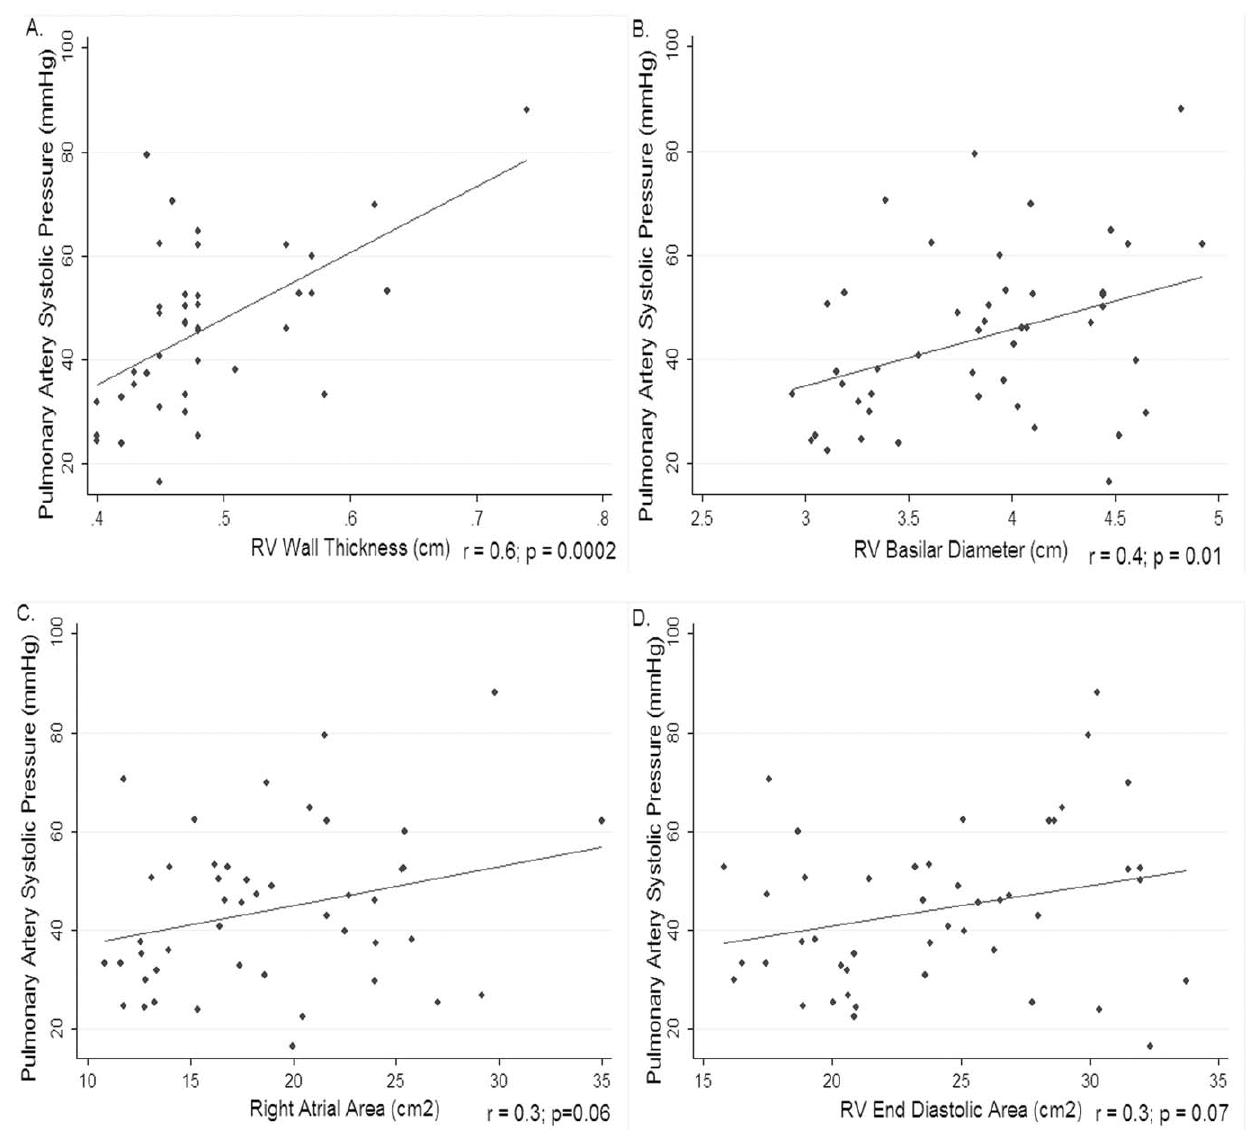
Figure 1. The correlation between right ventricular echocardiographic parameters and pulmonary artery systolic pressure estimates. Panel 1A: The correlation between pulmonary artery systolic pressure (mmHg) and right ventricular wall thickness (cm). Panel 1B: The correlation between pulmonary artery systolic pressure (mmHg) and right ventricular basilar diameter (cm). Panel 1C: The correlation between pulmonary artery systolic pressure (mmHg) and right atrial area (cm 2 ). Panel 1D: The correlation between pulmonary artery systolic pressure (mmHg) and right ventricular end diastolic area (cm 2 ).